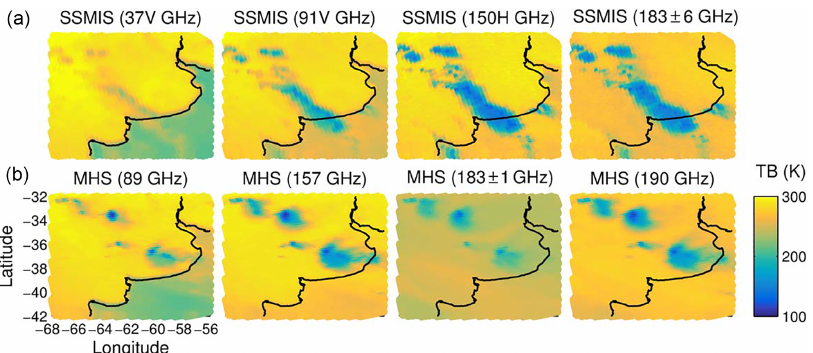
Figure 16. Coincident microwave observations for two MCS events of interest. (a) Observed brightness temperatures for selected SSMI/S channels over south-eastern South America on 13 January 2011 at 22:00UTC. (b) Observed brightness temperatures for selected MHS channels over south-eastern South America on 23 January 2014 at 02:00UTC.